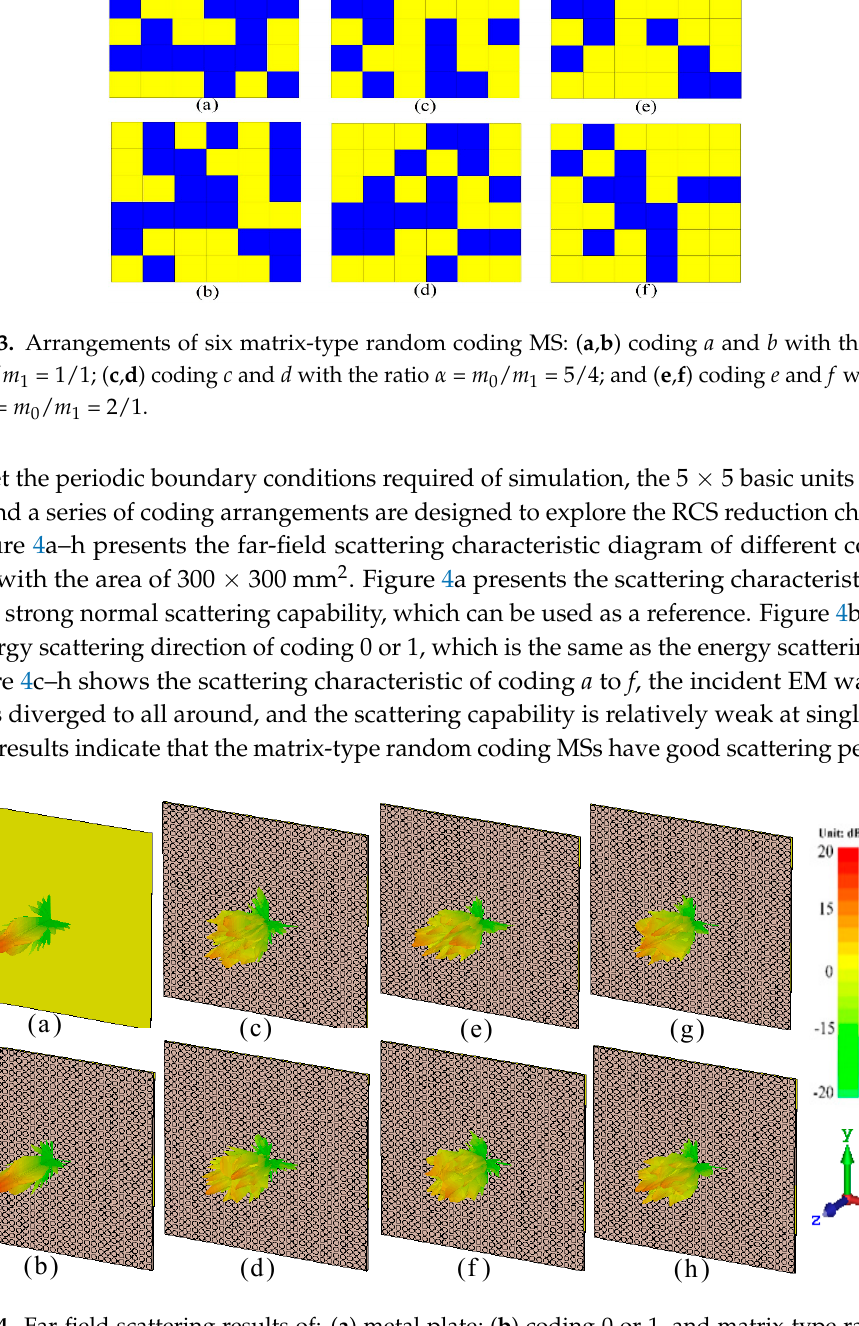
Figure 4. Far-field scattering results of: ( a ) metal plate; ( b ) coding 0 or 1, and matrix-type random coding MS; ( c ) coding a ; ( d ) coding b ; ( e ) coding c ; ( f ) coding d ; ( g ) coding e ; and ( h ) coding f at 9.5 GHz.